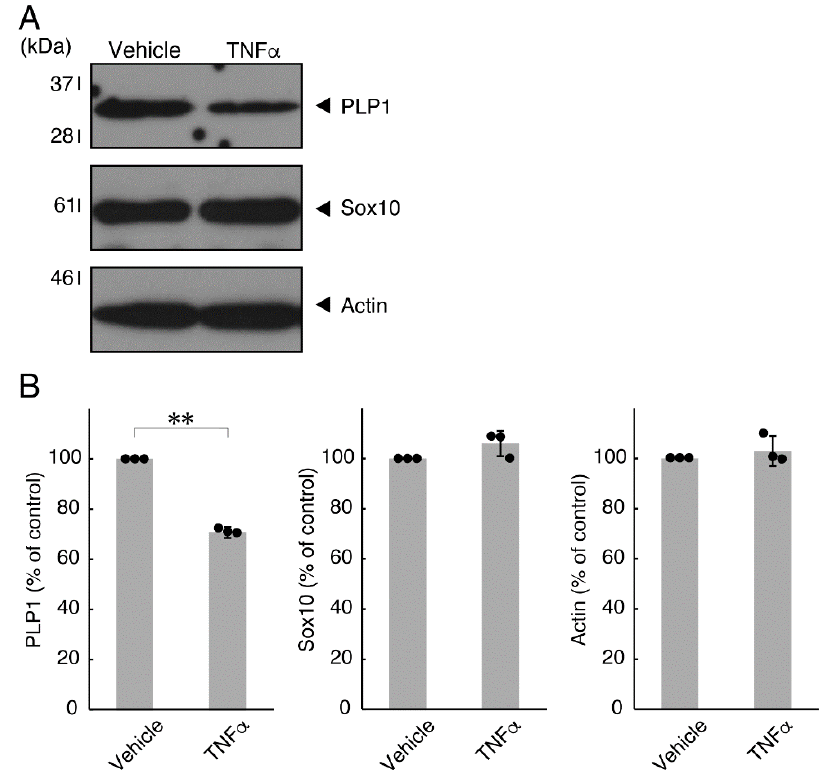
Figure 2. Effects of TNF α on oligodendroglial cell marker protein expression. ( A , B ) Cells were treated with TNF α or control vehicles. The PLP1, Sox10, or control actin blot is shown. Immunoreactive band intensities were also compared to be depicted in graphs (**, p < 0.01; n = 3 blots [obtaining one sample each from 3 independent experiments]).